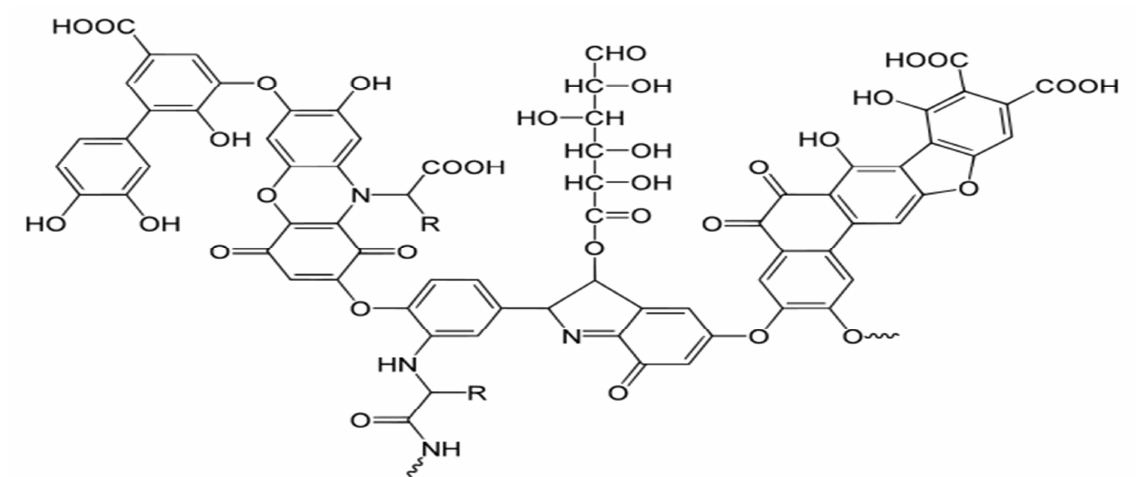
Figure 1. The proposed model for humic acid